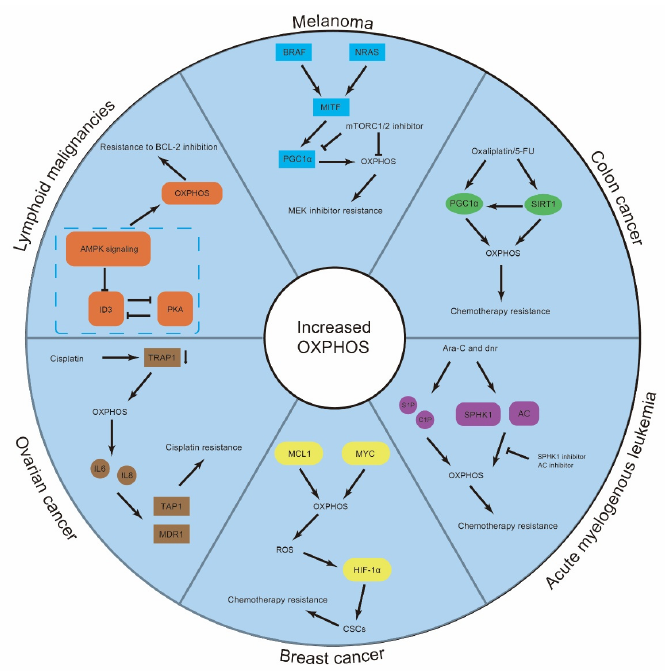
Figure 2. Resistant cancer cells display high OXPHOS activity. Activation of various oncogenic signaling pathways contributes to cancer drug resistance by upregulating OXPHOS activity in certain cancers, including breast cancer, ovarian cancer, and melanoma.